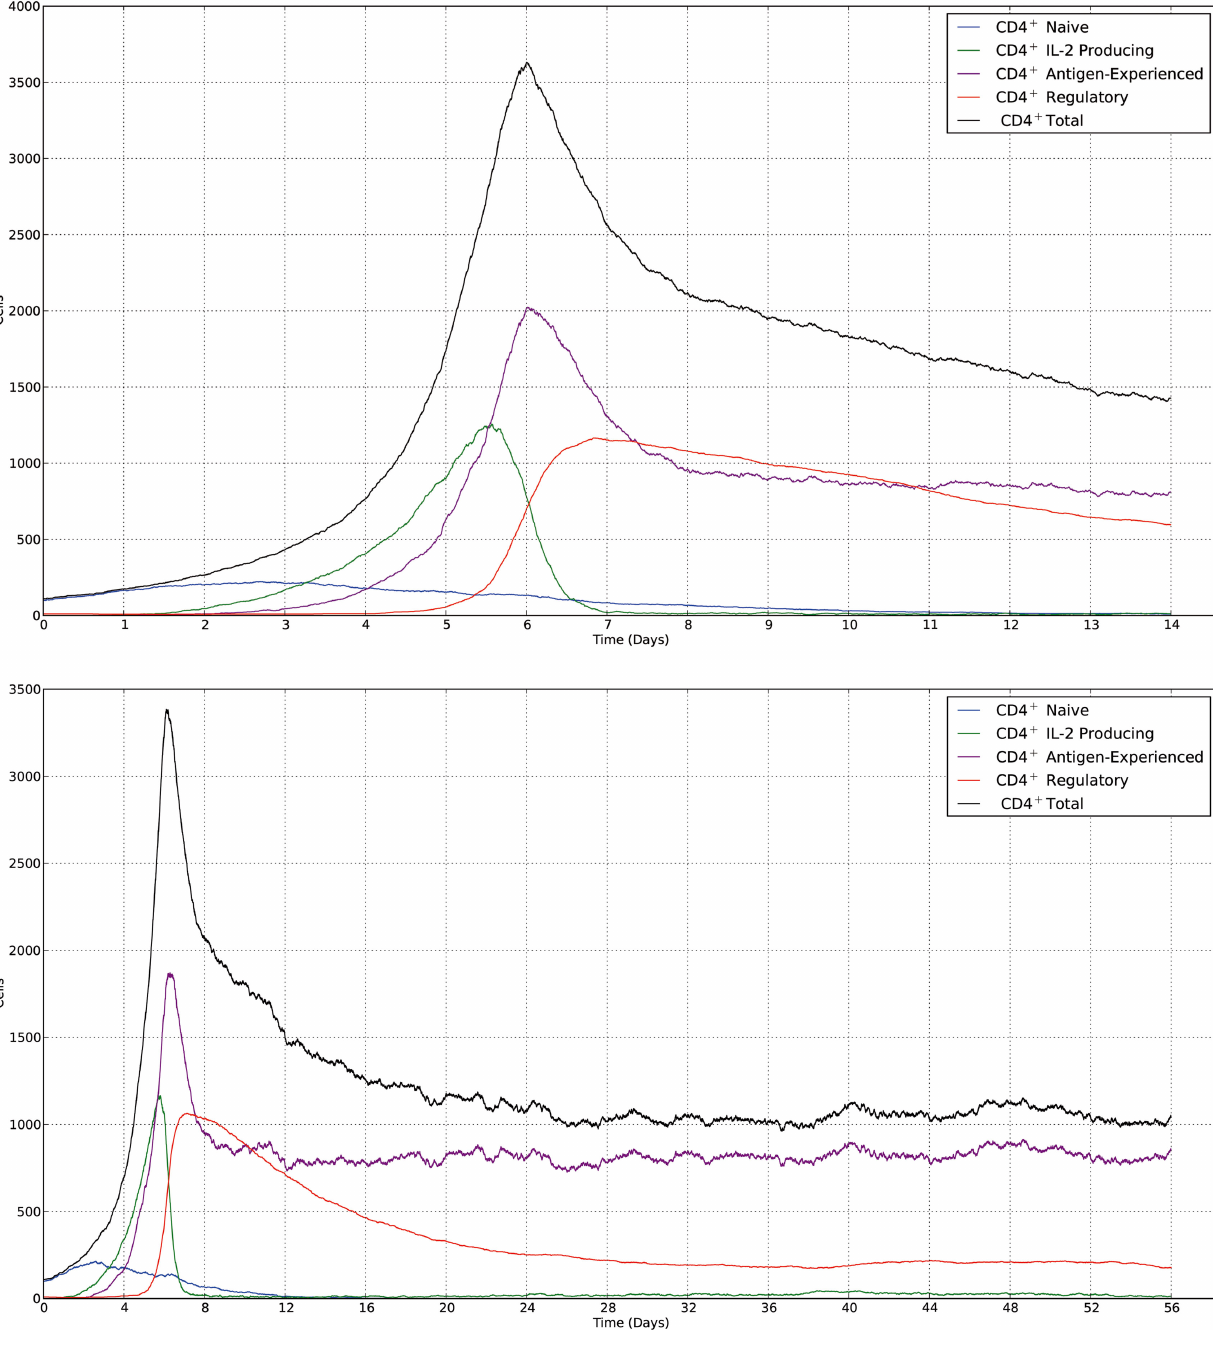
FIGURE 3 | Realizations of the stochastic model carried out using the Gillespie algorithm. All parameters and initial conditions are the same as in the deterministic model, with (A,B) , respectively, correlating to (A,B) from